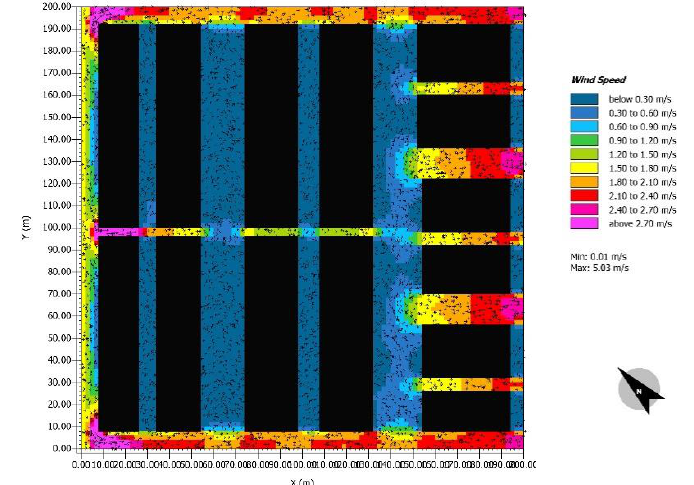
Figure 20. Wind speed and direction for Al Safa I urban form at 2:00 pm on August 15 (ENVI-met).